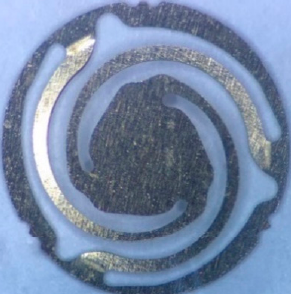
Figure 26. Novel spring sample (St = 0.15 mm).